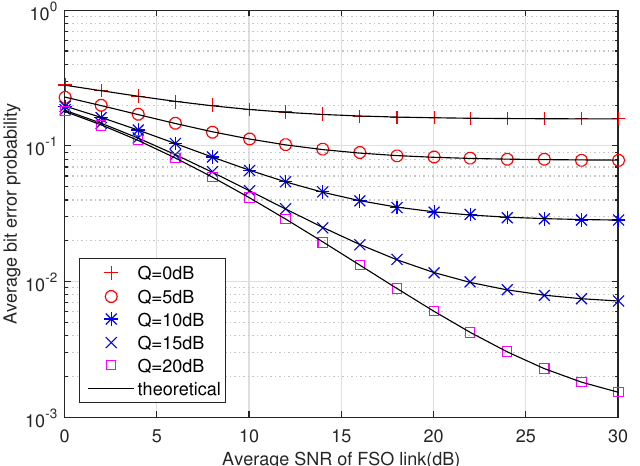
Figure 9. Average bit error probability under different interference threshold levels with heterodyne detection, where a = 2.064, b = 1.342 and ξ =